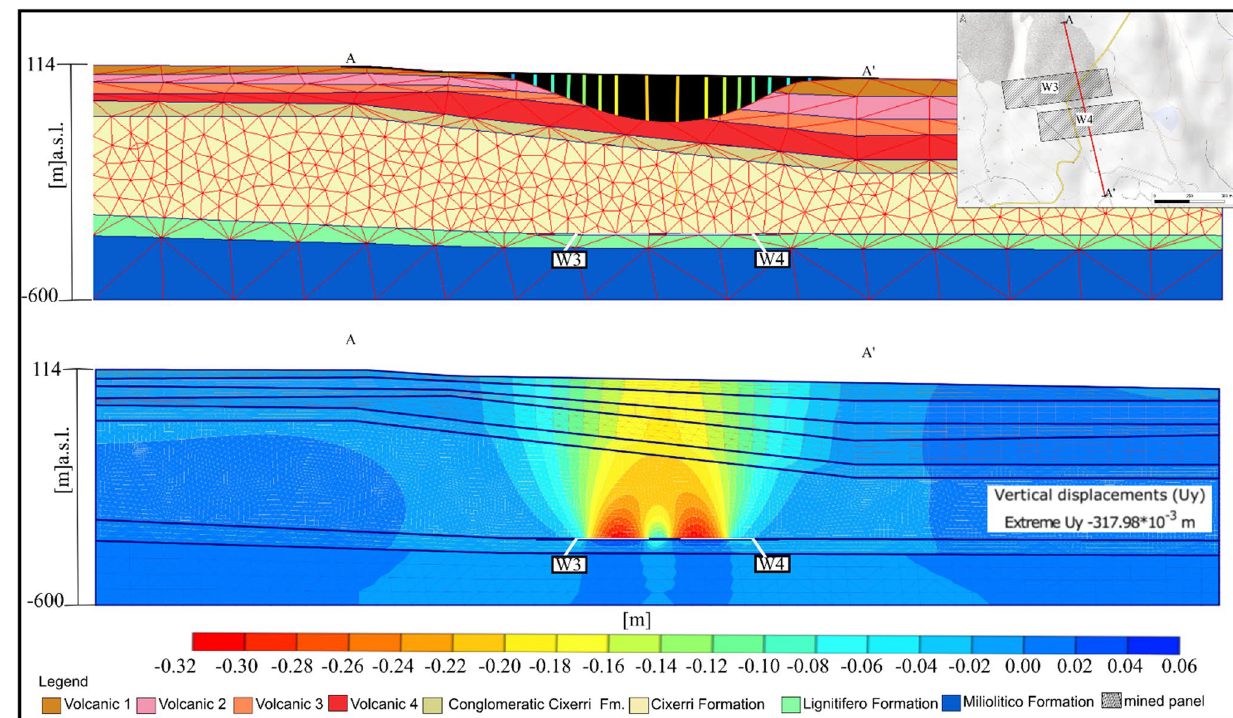
Fig. 7 Vertical displacements obtained by means of the geotechnical numerical model. On top subsidence profile related to the section AA